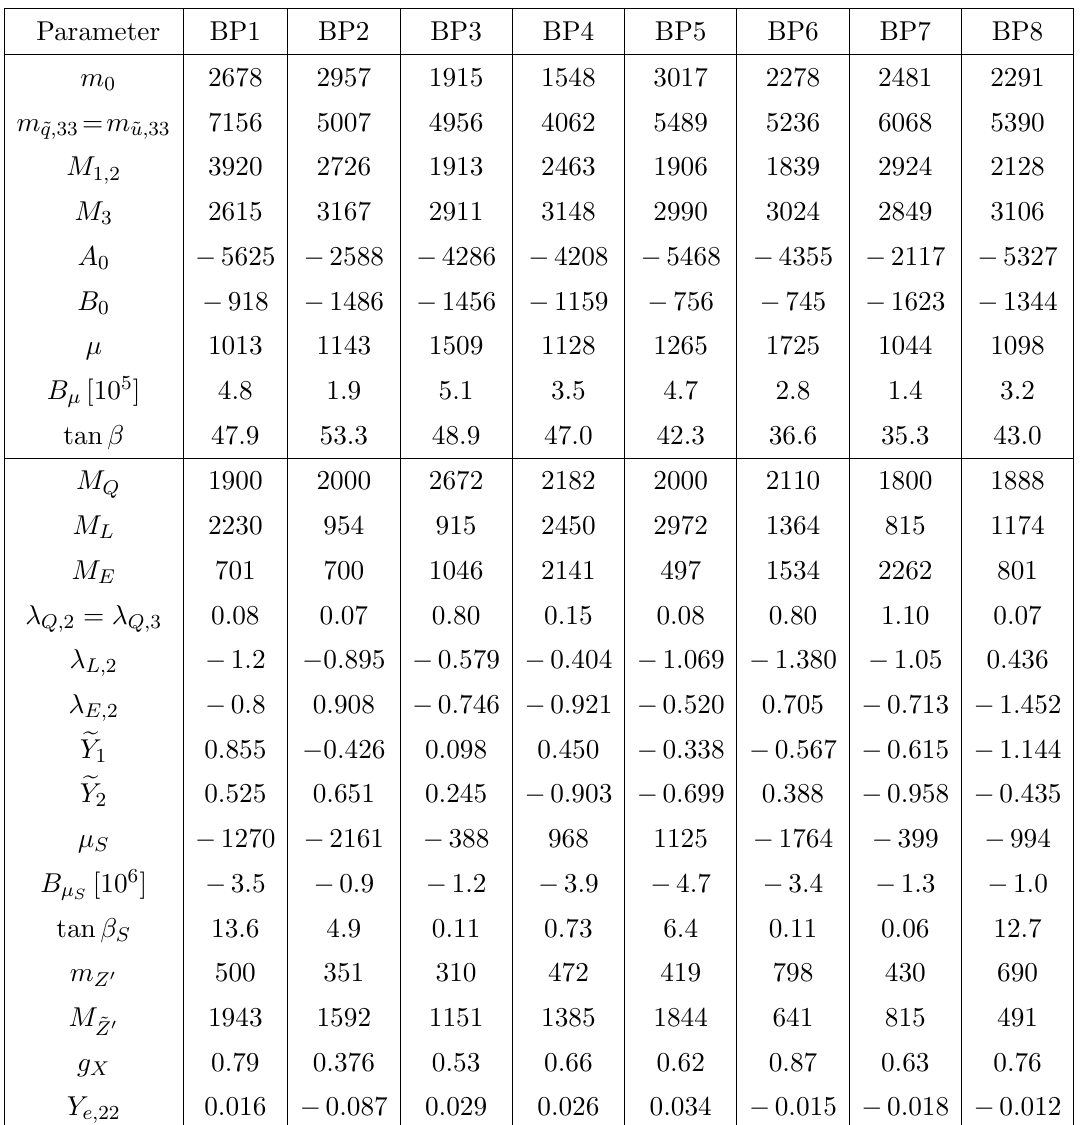
Table 1. Input parameters at the SUSY scale for our benchmark scenarios. Dimensionful quantities are given in GeV and GeV 2